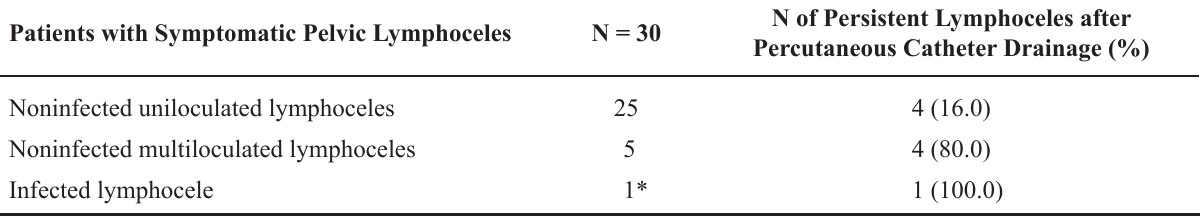
Table 2 – Classification of symptomatic pelvic lymphoceles and the results after performing percutaneous catheter drain- age